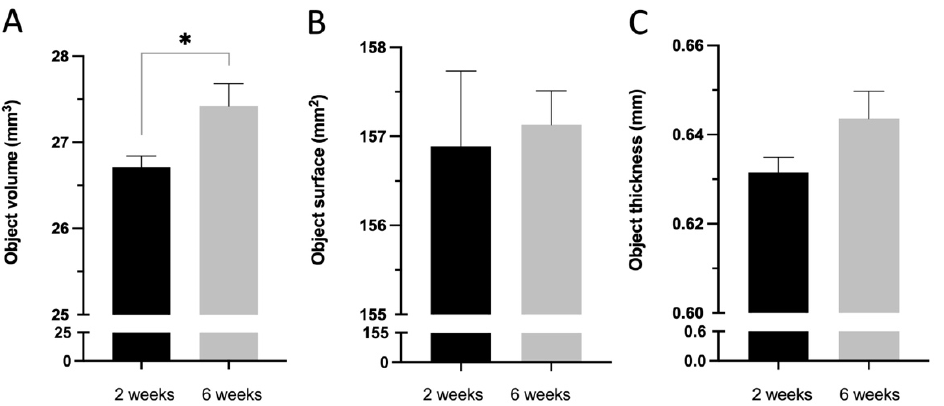
Figure 13. Micro-CT degradation analysis of the Fe SA groups 2 and 6 weeks postoperation in ( A ) Objective volume (mm 2 ), ( B ) Object surface (mm 2 ), and ( C ) Object thickness (mm). Mean ± SEM. * p < 0.05.